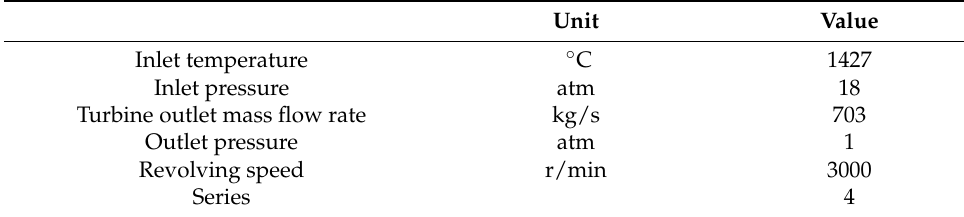
Table 1. Main parameters for the turbine.